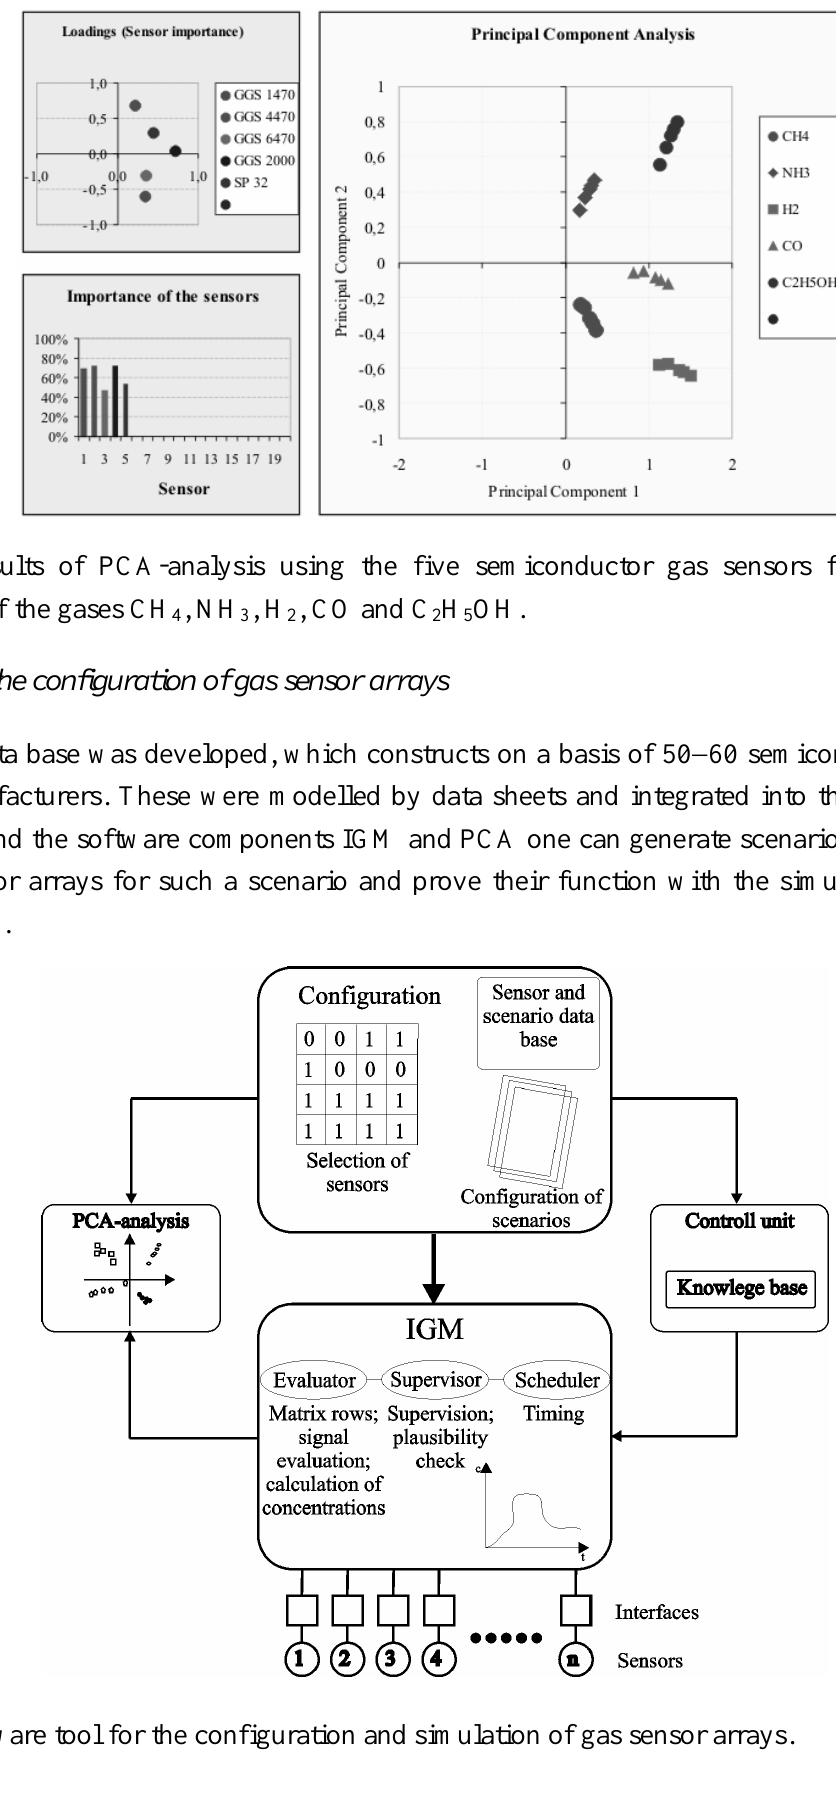
Figure 8. Software tool for the configuration and simulation of gas sensor